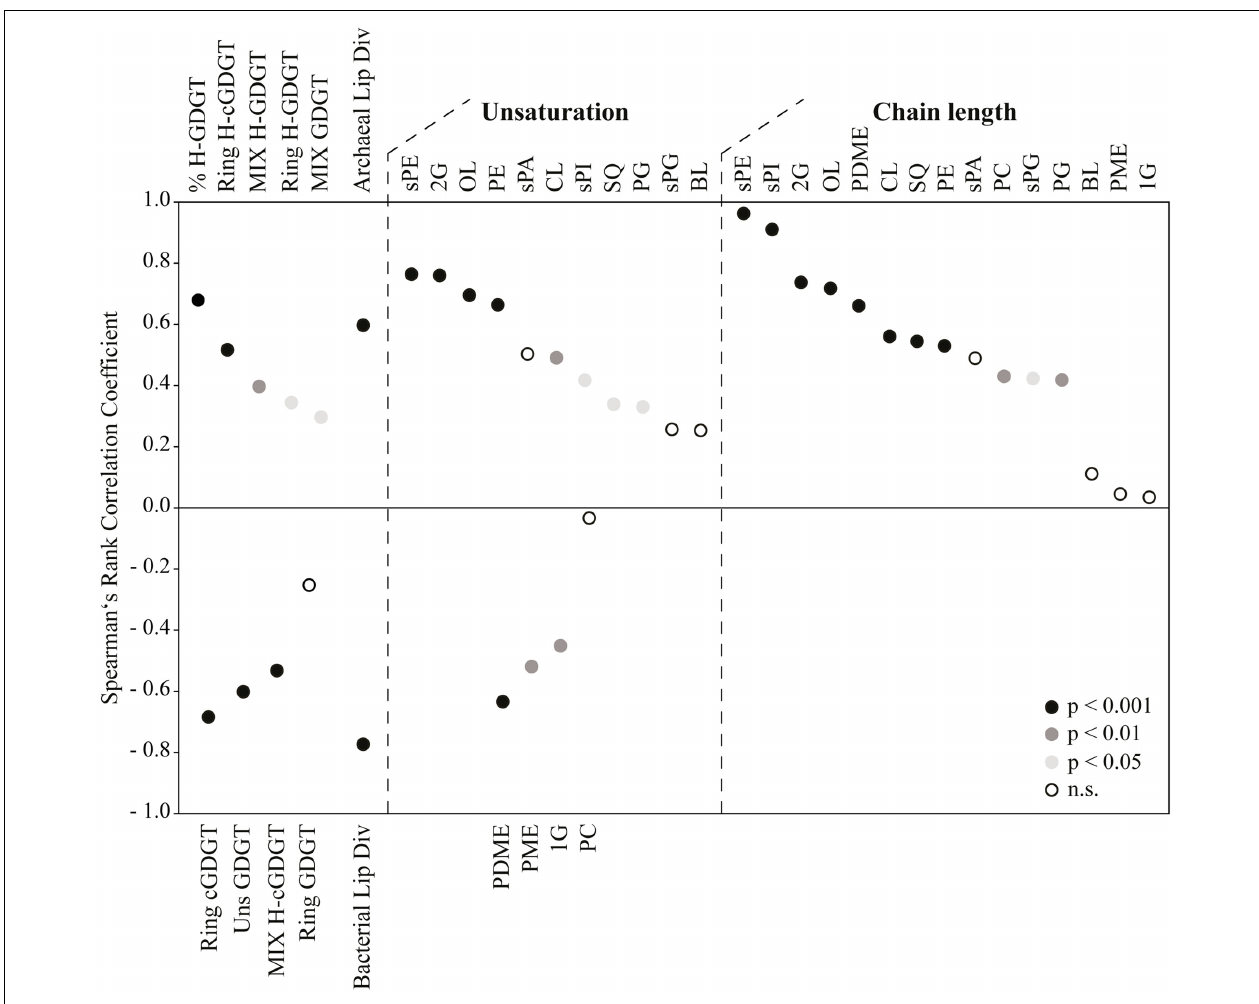
FIGURE 5 | Analysis of molecular species of archaeal and non-archaeal lipids as a function of temperature. Spearman’s rank correlation coefficient values corresponding to positive or negative correlation (see Materials and Methods and Supplementary Table S2) between lipid parameters and temperature are displayed as circles, with colors indicating the level of significance ( p < 0.001, p < 0.05, p < 0.01 or not significant, n.s.). Archaeal/Bacterial Lip Div, archaeal/bacterial lipid diversity. Please see Supporting Information for details about lipid parameters used as input to the correlation